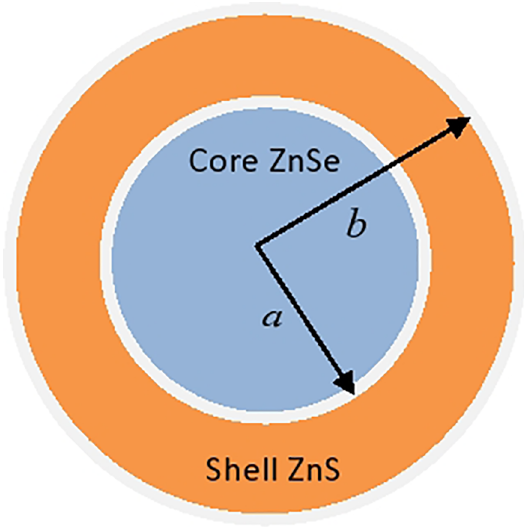
Figure 1. Schematic representation of ZnSe/ZnS core shell quantum